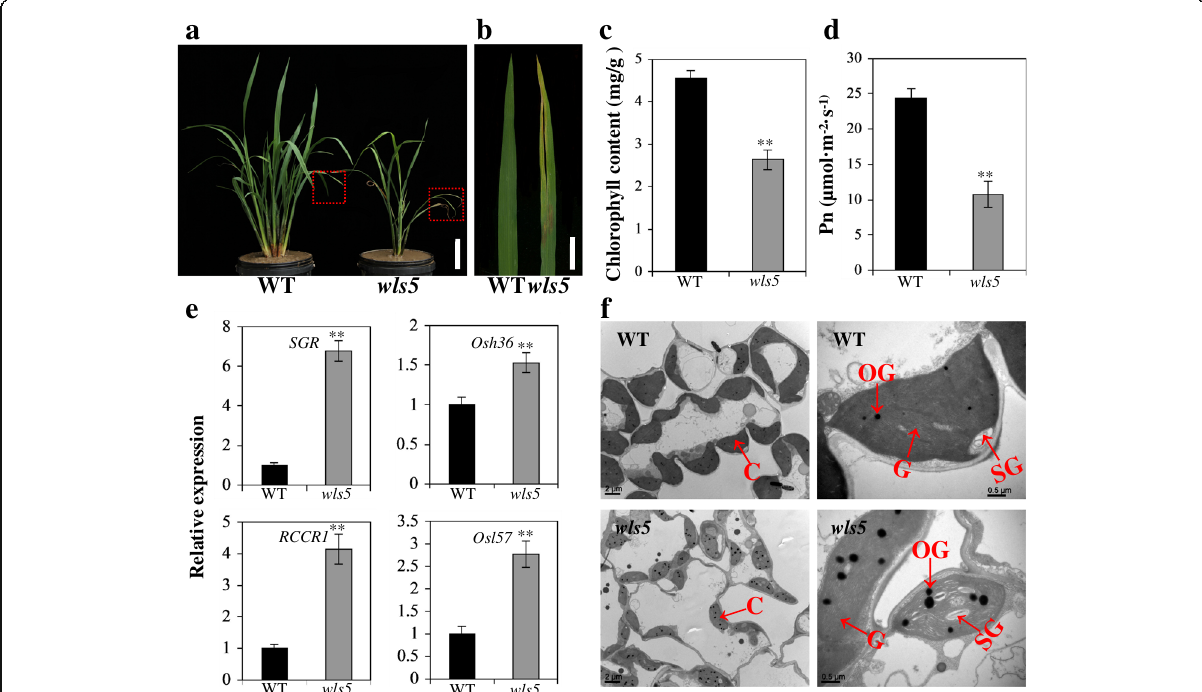
Fig. 3 Identification of leaf senescence in wls5 . a Wild-type (WT; ‘ 93 – 11 ’ ) and wls5 plants at the tillering stage. Bar = 10 cm. b Leaf phenotype of WT and wls5 plants. Bar = 2 cm. c Chlorophyll content of leaves in wild-type and wls5 plants. Error bars indicate SD, n = 10. ** P < 0.01 (Student ’ s t - test). d Photosynthesis rate of leaves in wild-type and wls5 plants. Error bars indicate SD, n = 15. ** P < 0.01 (Student ’ s t -test). e Expression of CDGs ( SGR and RCCR1 ) (left) and other SAGs ( Osh36 and Osl57 ) (right) in WT and wls5 plants. Error bars indicate SD, n = 3. ** P < 0.01 (Student ’ s t- test). f Transmission electron microscopy of senescing leaves of WT and wls5 plants at seedling stage. C, chloroplast; OG, osmiophilic granule; SG, starch granule; G, grana thylakoid